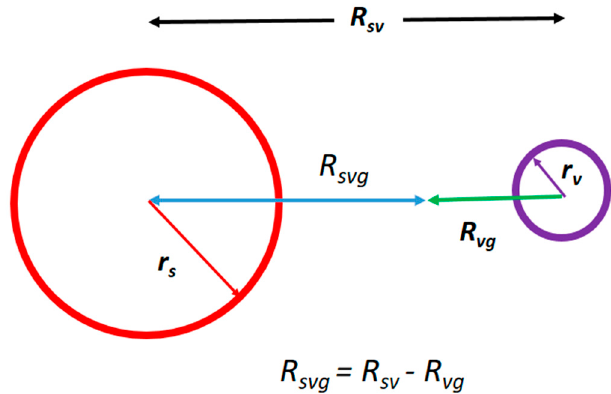
Figure 1. The schematic of distances of the geosynchronous orbit of Venus.